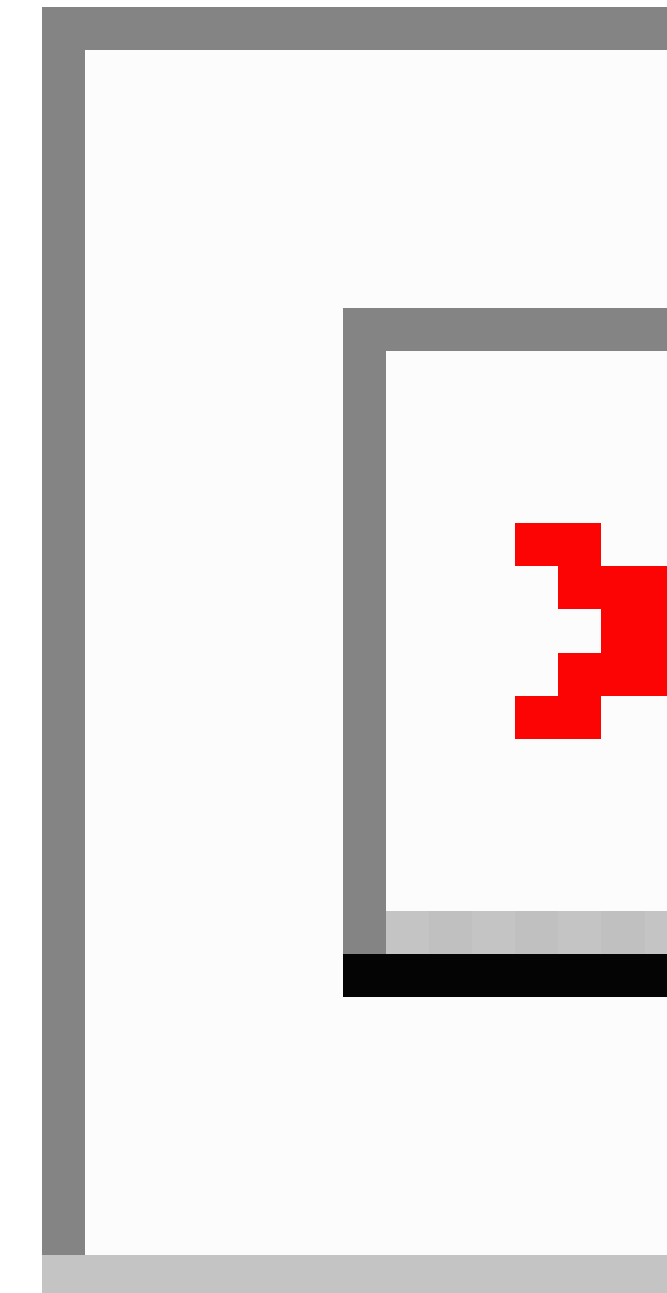
Figure 2. The creation process of the knowledge flow